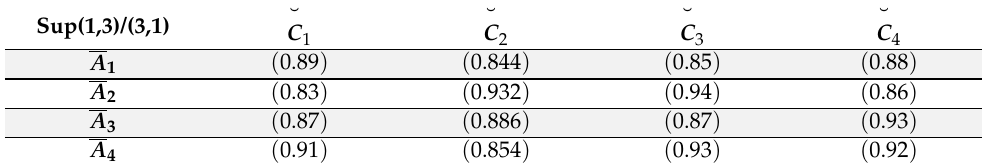
Table 5. Decision matrix of calculated support values established from Tables 1 and 3.